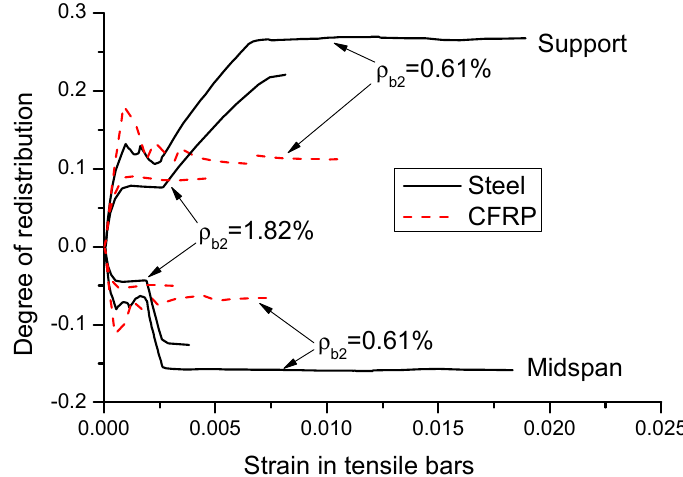
Figure 12. Moment redistribution versus bar strain curves. The change in the strain in tensile bars ( ε t ) and moment redistribution ( β ) in failure with the ρ b 2 level is displayed in Figures 13 and 14, respectively. The results are also pre- sented in Table 1. It is observed that the bar strain at center support is higher than that at midspan. The strain in CFRP bars is significantly lower than that in steel bars at a low ρ b 2 level, but it is close or comparable to that in steel bars at a high ρ b 2 level. Moment redistri-